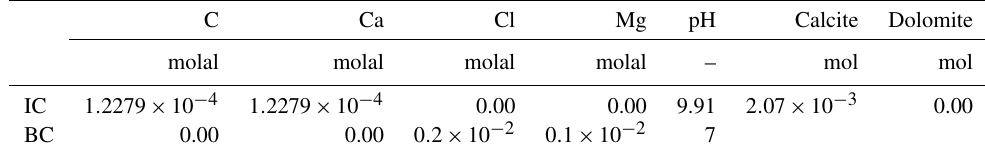
Table 2. Initial conditions (ICs) and boundary conditions (BCs) for the benchmark problem. C Ca Cl Mg pH Calcite Dolomite molal molal molal molal mol